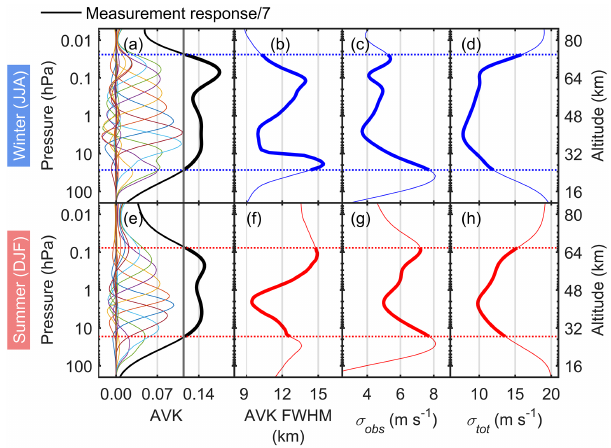
Figure 5. Example zonal wind retrievals for simulated clear-sky, 12h observations (i.e. 6h in east and 6h in west directions) of the O 3 231.28GHz line using a ground-based radiometer with a 1400K system temperature, 30kHz frequency resolution, and 60 ◦ zenith viewing angle located at Halley station (75 ◦ 37 (cid:48) S, 26 ◦ 14 (cid:48) W), Antarctica. In (a) and (e) every sixth averaging kernel, and the scaled measurement response (MR), are shown for mean winter (JJA) and summer (DJF) conditions respectively. The vertical grey lines in (a) and (e) , dashed horizontal lines, and the thicker sections of the plots indicate where MR ≥